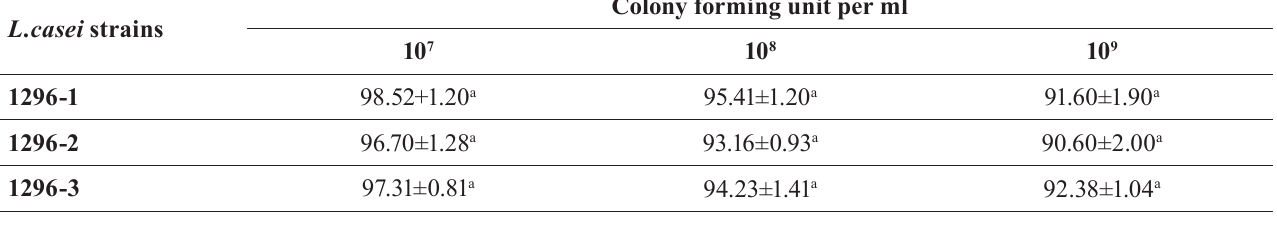
TABLE I - C ell viability of MRC 5 (a) and CaCo2 (b) cell lines after exposure to different concentrations of live (Probiotic) L. casei strains, after 72 hrs by MTT assay (a)